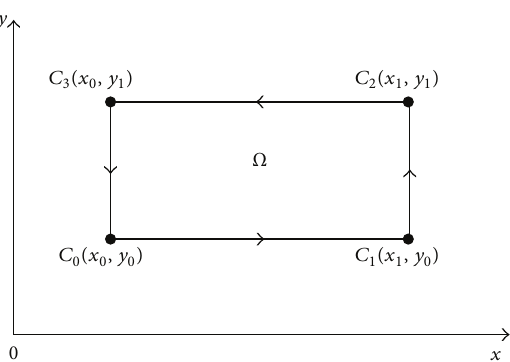
Figure 2: The two-dimensional simply connected space Ω and its piecewise smooth boundary curve 𝐶 .